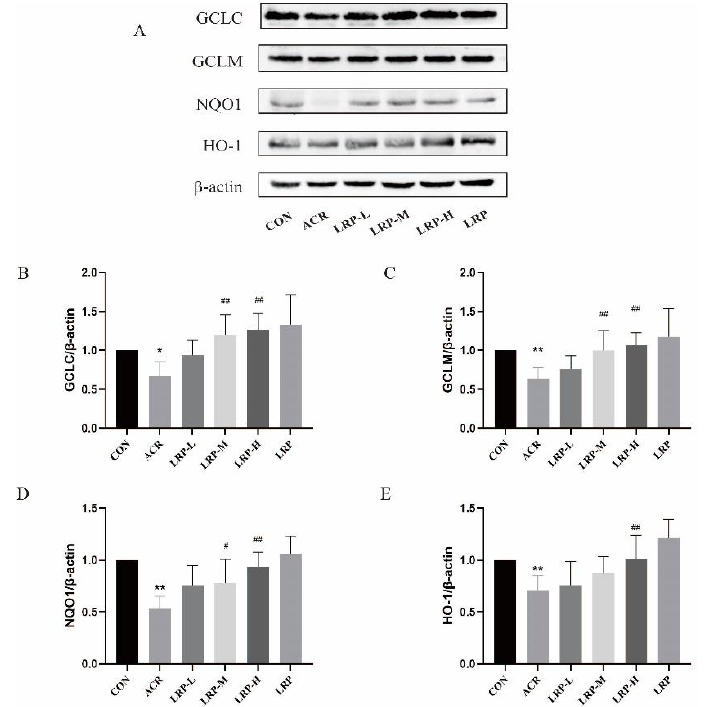
Figure 6. ( A ) Effect of LRP on the expression of HO-1, GCLC, GCLM, and NQO1 in the liver. The protein expression analysis from the liver of an experimental rat using HO-1, GCLC, GCLM, and NQO1 antibodies. The data of the densitometric analysis of ( B ) GCLC/ β -actin, ( C ) GCLM/ β -actin, ( D ) NQO1/ β -actin, ( E ) HO-1/ β -actin. Data are expressed as mean ± SD. * p < 0.05 and ** p < 0.01 versus the CON group; # p < 0.05 and ## p < 0.01 versus the ACR group. ACR, acrylamide; LRP-L, Lycium ruthenicum polyphenols in low dosage; LRP-M, Lycium ruthenicum polyphenols in medium dosage; LRP-H, Lycium ruthenicum polyphenols in high dosage; LRP, Lycium ruthenicum polyphenols control group.